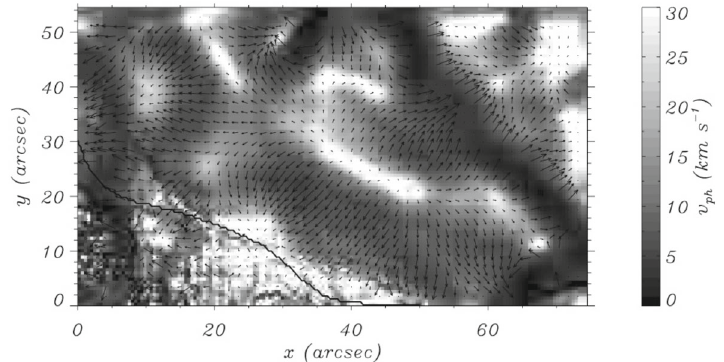
Fig. 27 Arrows represent the wavevector field computed from the gradient of the Fourier phase displayed in Fig. 26, where the length of the arrows is proportional to the modulus of the wavevector. The phase velocity is shown with the help of different levels of grey and black and white colours. Image reproduced with permission from Terradas et al. (2002), copyright by